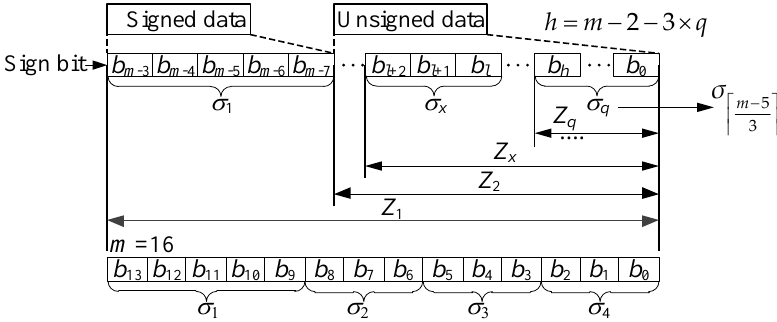
σ σ and the variable Figure 3. The architectures of the variable i and the variable Z i ( Z i i